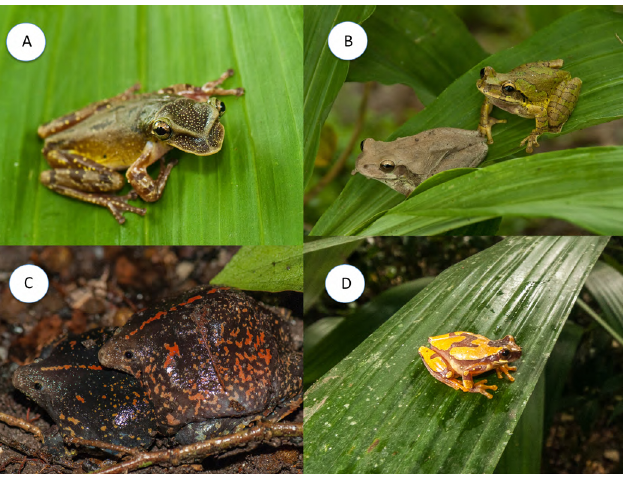
Figure 7. Amphibians encountered in the Calakmul Biosphere Reserve: ( A ) Triprion petastatus, ( B ) Smilisca baudinii, ( C ) Rhinophrynus dorsalis, ( D ) Dendropsophis ebracatta. Photos by TJC.